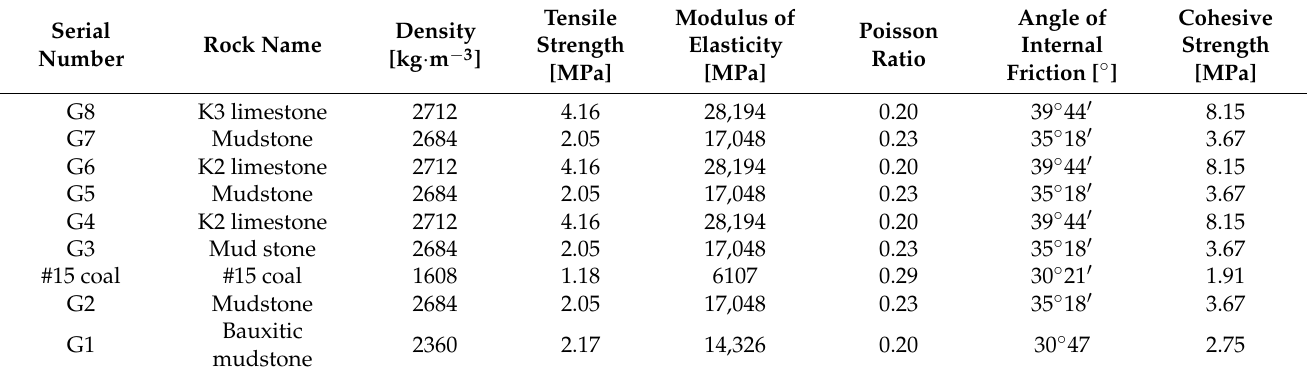
Table 2. Determination results of the physical and mechanical parameters of the #15 coal